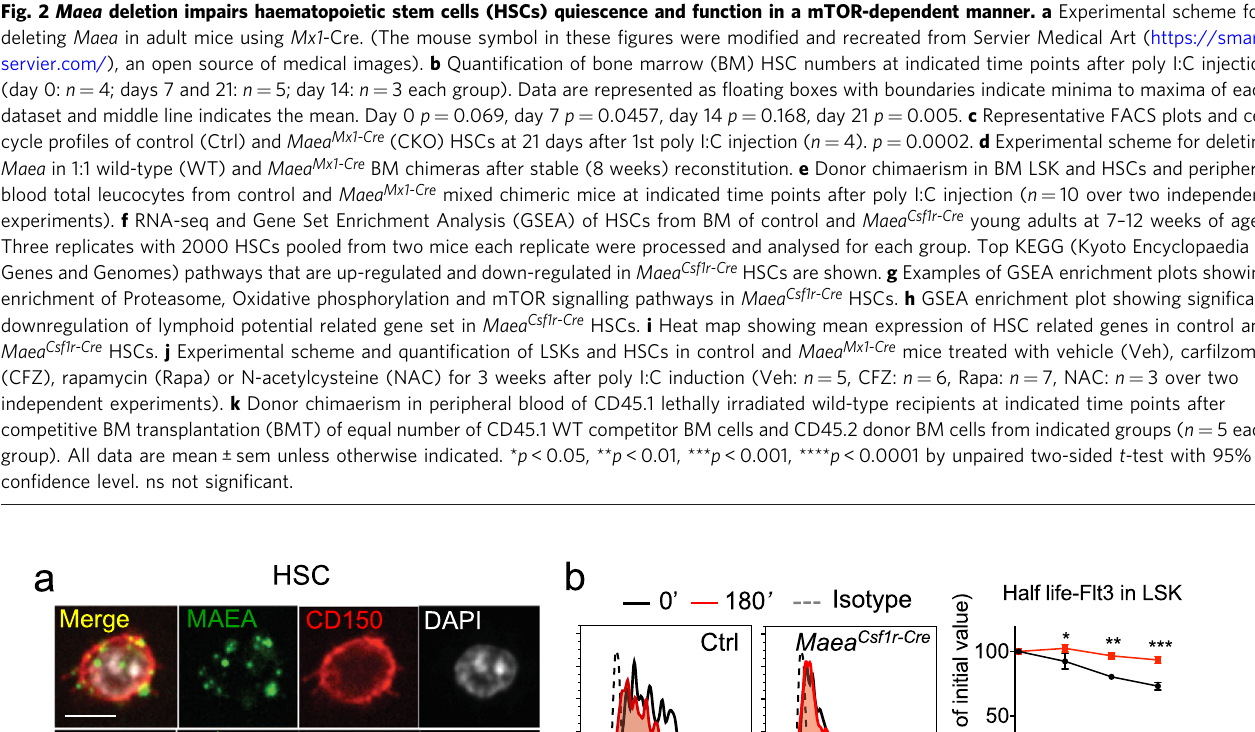
Fig. 2 Maea deletion impairs haematopoietic stem cells (HSCs) quiescence and function in a mTOR-dependent manner. a Experimental scheme for deleting Maea in adult mice using Mx1 -Cre. (The mouse symbol in these fi gures were modi fi ed and recreated from Servier Medical Art (https://smart. servier.com/), an open source of medical images). b Quanti fi cation of bone marrow (BM) HSC numbers at indicated time points after poly I:C injection